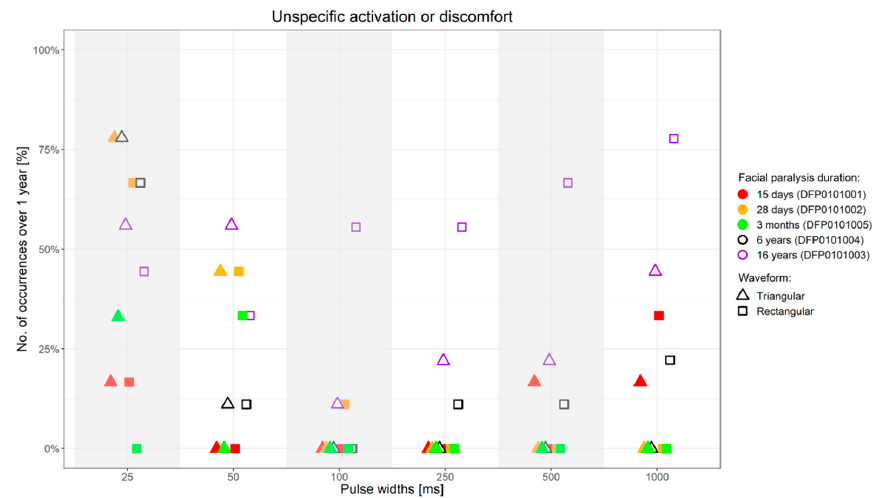
Figure 7. Percentage of occurrence of discomfort or unselective facial muscle response before reaching an amplitude sufficient to elicit a selective ZYG response ( y -axis) when the stimulation was presented with specific PWs ( x -axis) over 1-year follow-up upon first stimulation. ms = milliseconds.